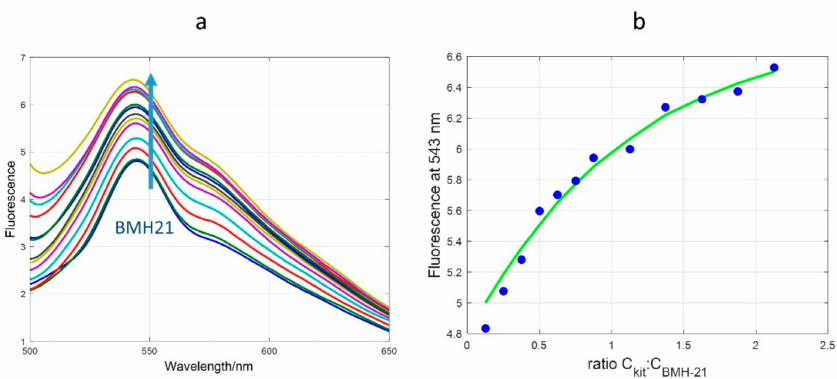
Figure 5. ( a ) Fluorescence spectra recorded along the titration of BMH-21 ( 1 ) with c-kit21T12T21. ( b ) Original fluorescence signal at 535 nm for the titration of BMH-21 ( 1 ) at di ff erent concentrations of